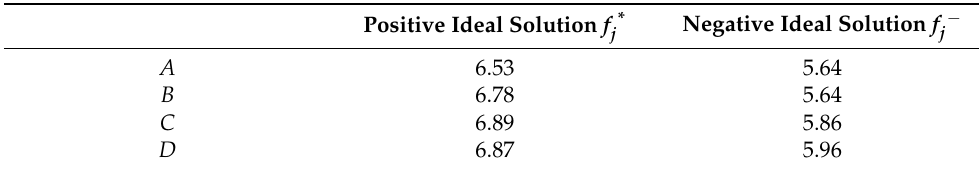
Table 9. Positive and negative ideal solutions of the primary indicators for the social effect evaluation of six enterprises’ carbon accounts.